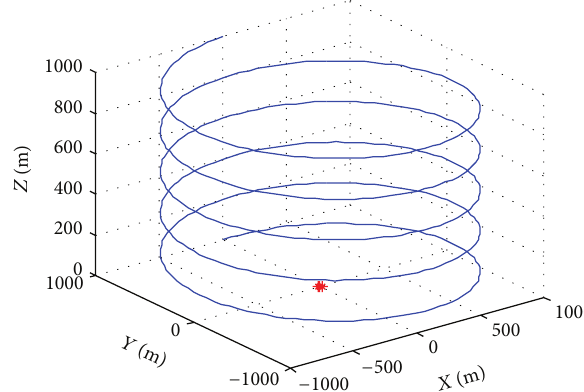
Figure 14: A simulated lightning leader’s path in the form of a